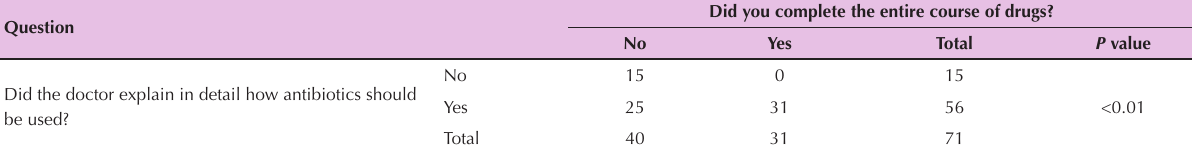
Table 3. Doctor’s explanation vers antibiotic course completion